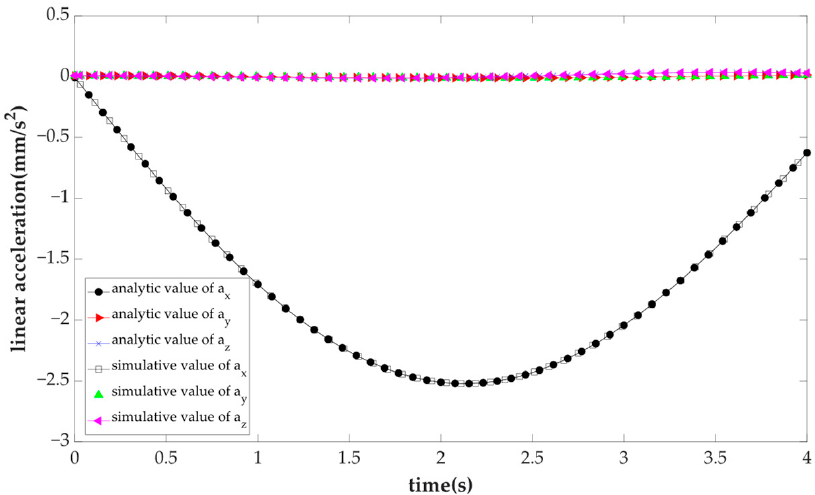
Figure 11. The comparison between analytic results and simulative results of angular velocity of m .